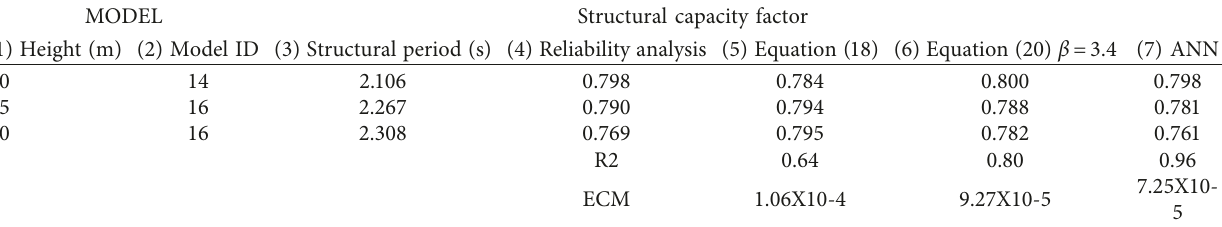
Table 8: Comparison of structural capacity factor results.